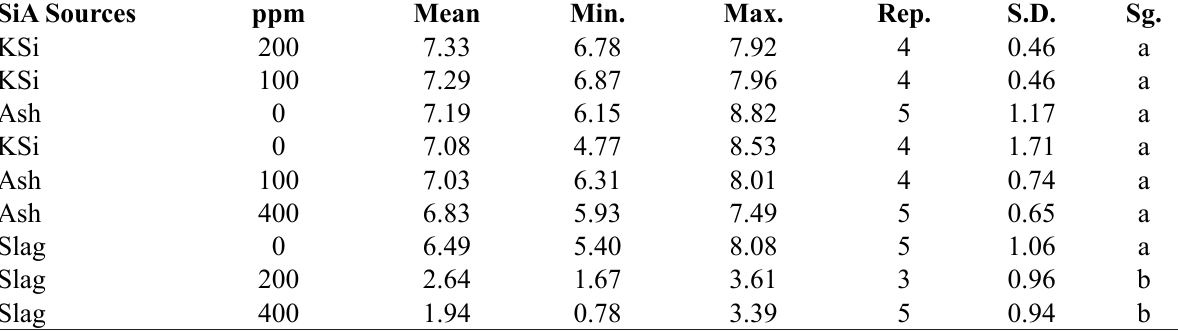
Table 7. Statistical summary of silicon concentration (%) in roots. Significance levels were obtained with Tukey test, α = 0.05.